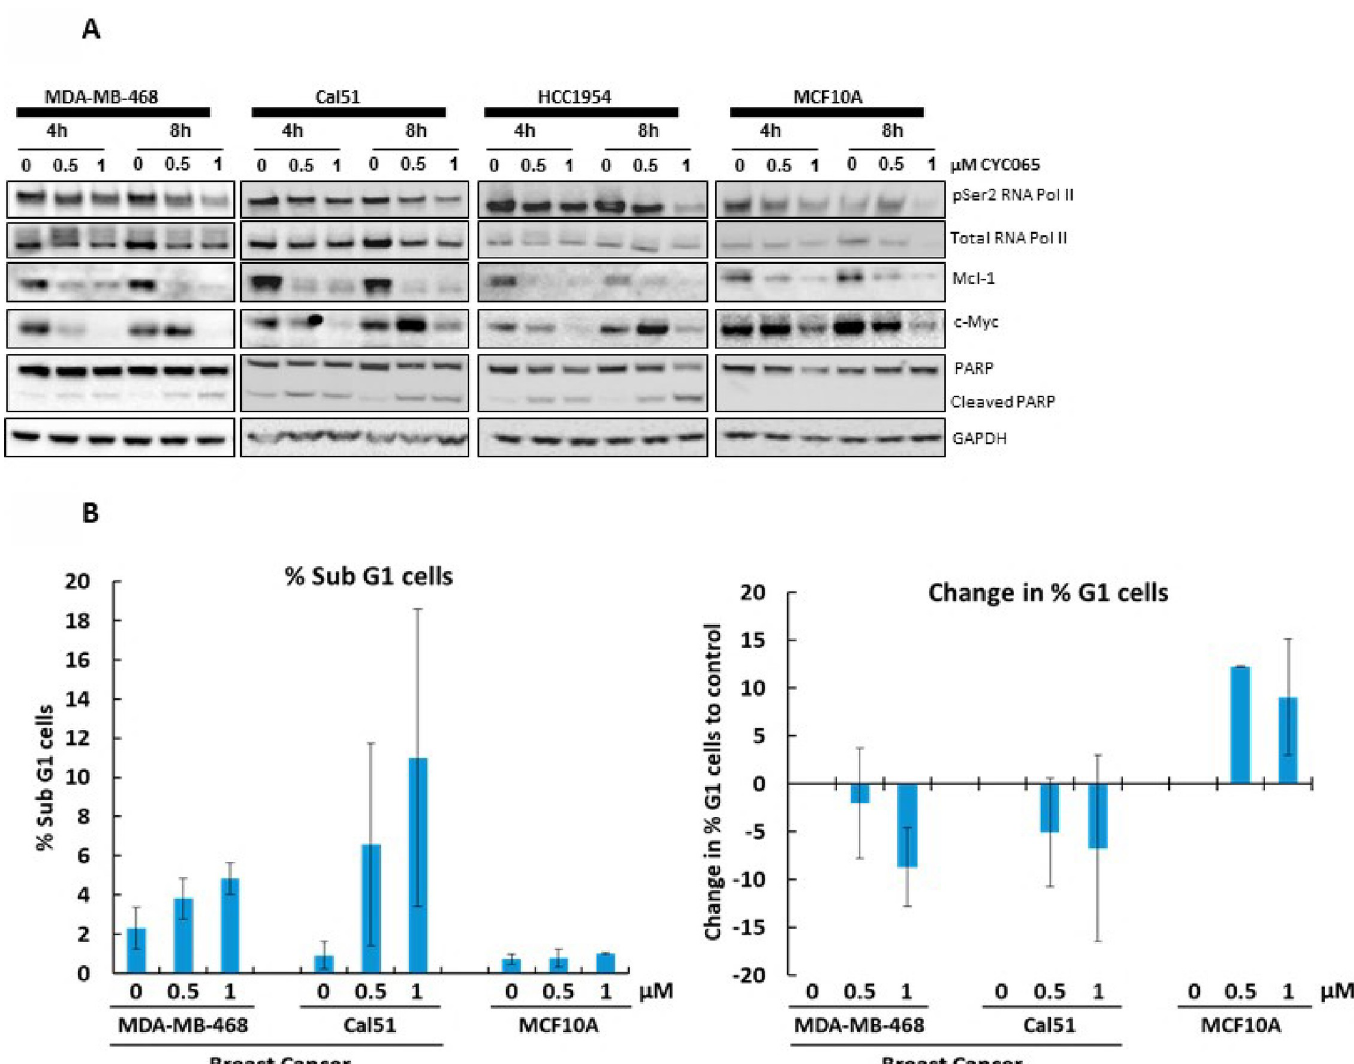
Fig 3. Fadraciclib (CYC065) is selectively cytotoxic to breast cancer cells. A . Representative human breast cancer cell lines and non-transformed cells derived from healthy breast tissue were exposed to fadraciclib (CYC065) for up to 8 h, and the expression levels of selected proteins was examined by Western blotting. B . Cells were treated with vehicle, 0.5 μ M or 1.0 μ M fadraciclib (CYC065) for an 8 h pulse, then cells were harvested at 24 h for cell cycle analysis by propidium iodide staining. Error bars denote SD.